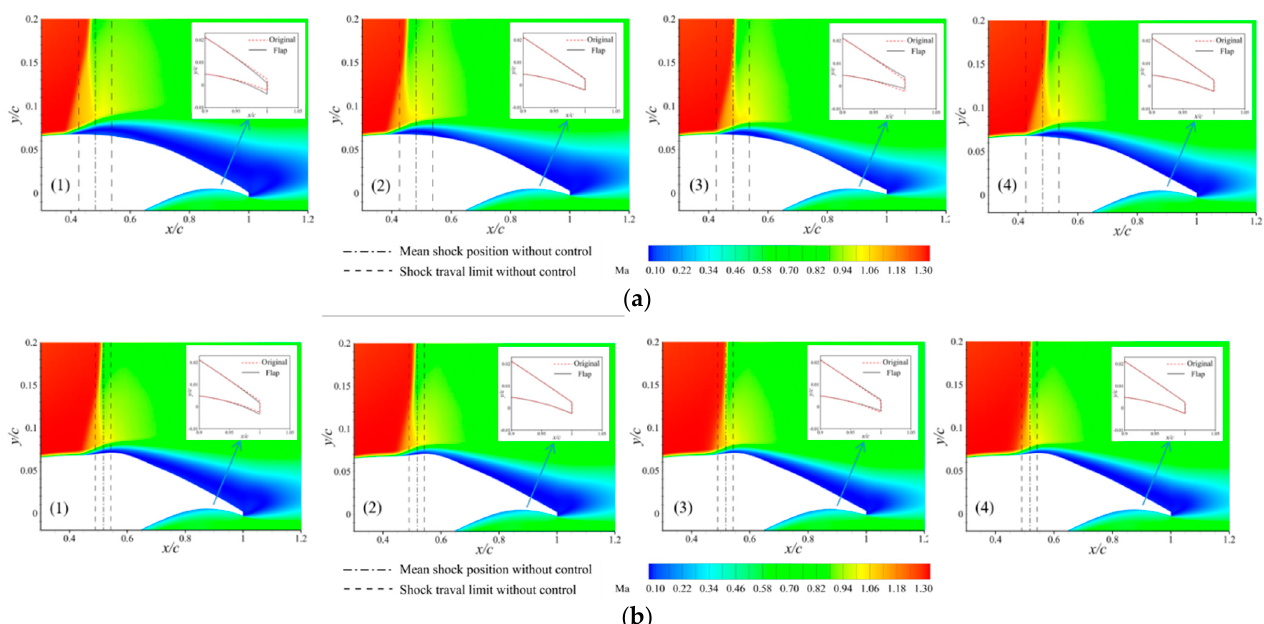
Figure 13. Instantaneous Mach number contours in different time phrases of flap control. ( a ) Basline configuration. ( b ) Bump 2 configuration.